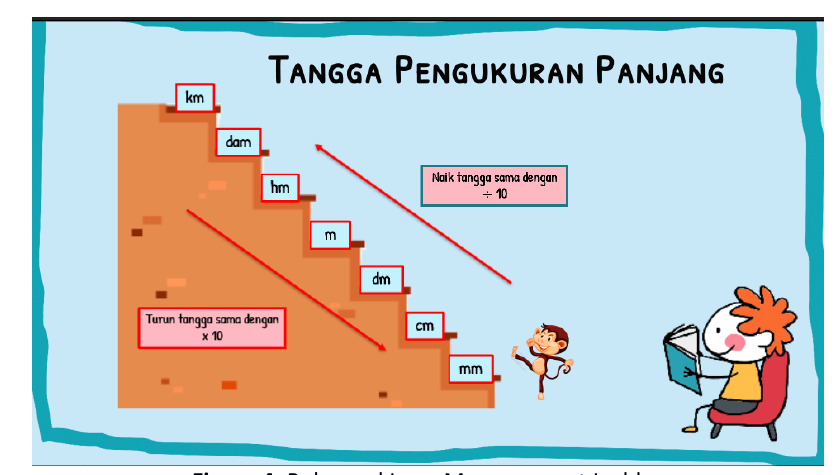
Figure 4. Bubu and Long Measurement Ladder